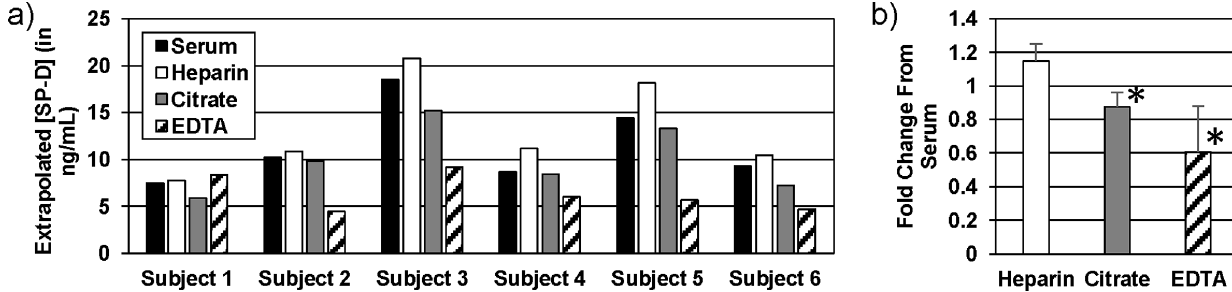
Figure 3. Detection of SP-D in serum and plasma collected using various anticoagulants. a) SP-D concentrations were measured in samples collected into four different vacutainers during a single blood draw. b) Measured values of samples were normalized to the SP-D concentration in serum for each patient in order to compare the effect of the anticoagulant on the measured SP-D concentration. An asterisk (*) denotes values are significantly different by Wilcoxon signed rank test (for EDTA, p=0.0156, and for Citrate,